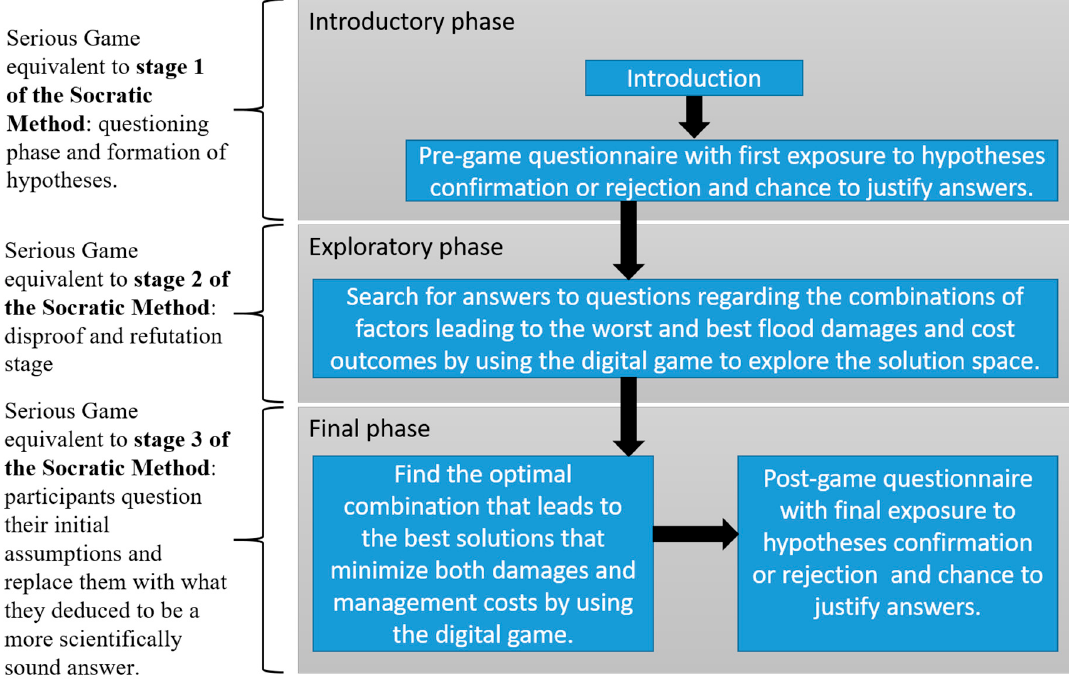
Figure 1. Three parts of the Serious Game process.